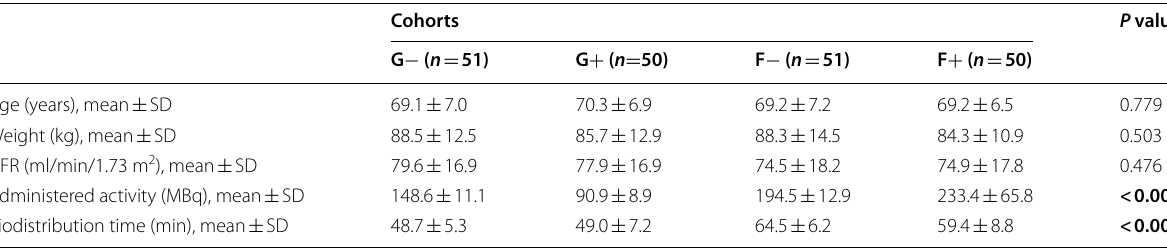
Biodistribution time (min), mean ± Bold values are significant GFR, glomerular filtration rate; SD, standard deviation * p values for overall cohort comparison from one-way ANOVA